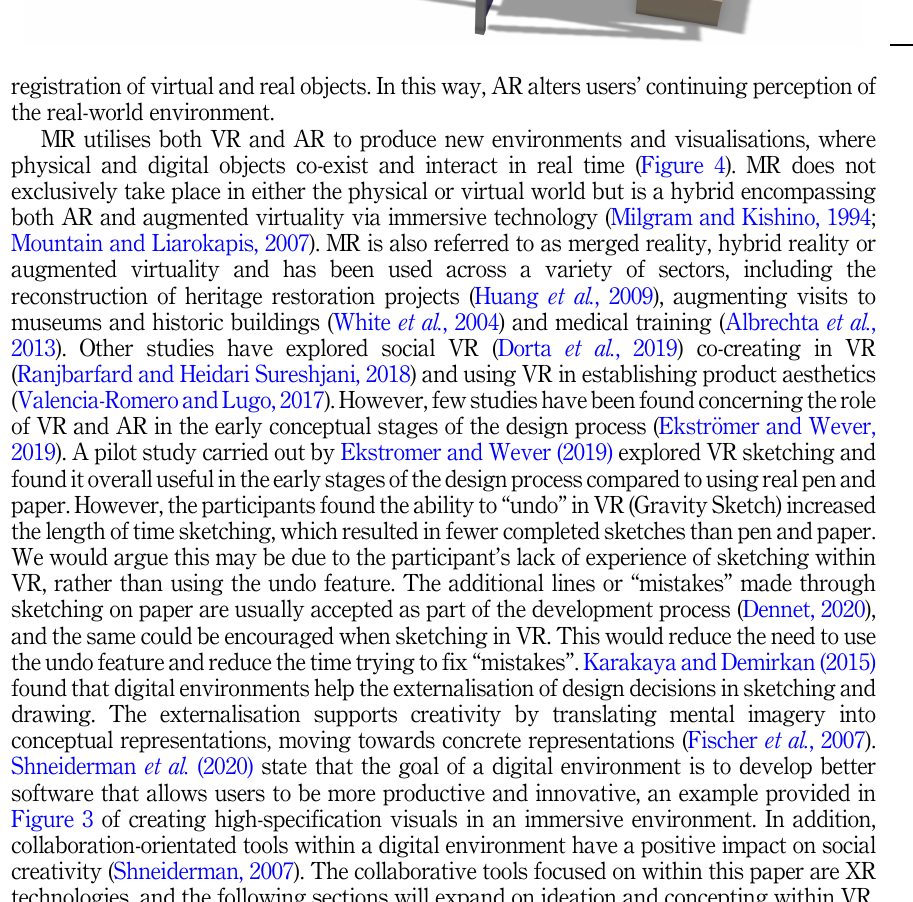
Figure 2. Visual